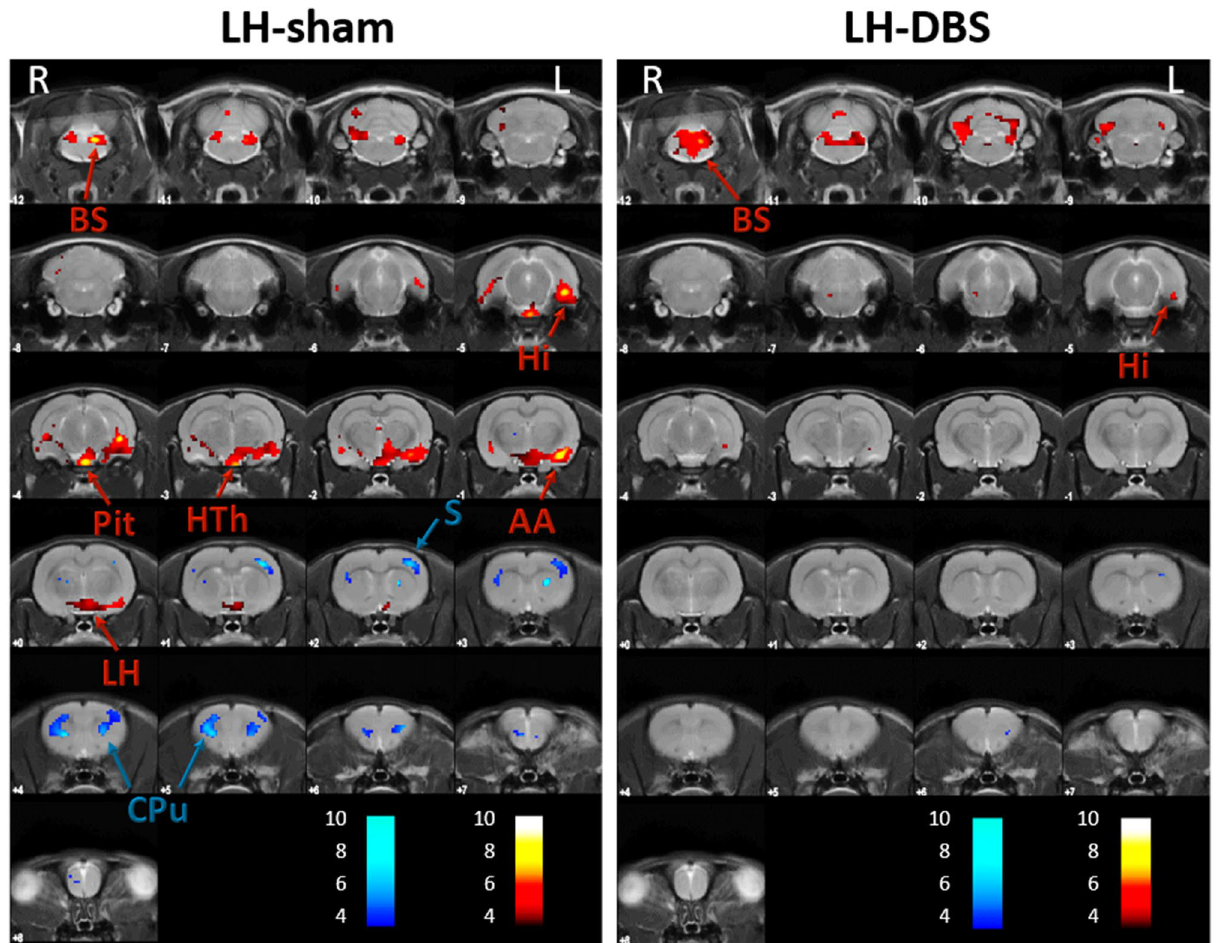
Figure 2. Persistence of DBS effects on brain metabolism 1 month after finishing LH-DBS treatment. Colored PET overlays on the MR reference represent the T-maps resulting from the post-1-month vs. post-1-day comparisons, indicating increased (hot colors) or decreased FDG uptake (cold colors), in LH-sham (left) and LH-DBS (right) animals, respectively. The color bars represent the T values scale corresponding to the PET overlays intensity. Hemispheres: Left (L), Right (R). AA amygdala, BS brainstem, Cb cerebellum, CPu caudate- putamen, Hi hippocampus, HTh hypothalamus, LH lateral hypothalamus, Pit pituitary gland S: somatosensory